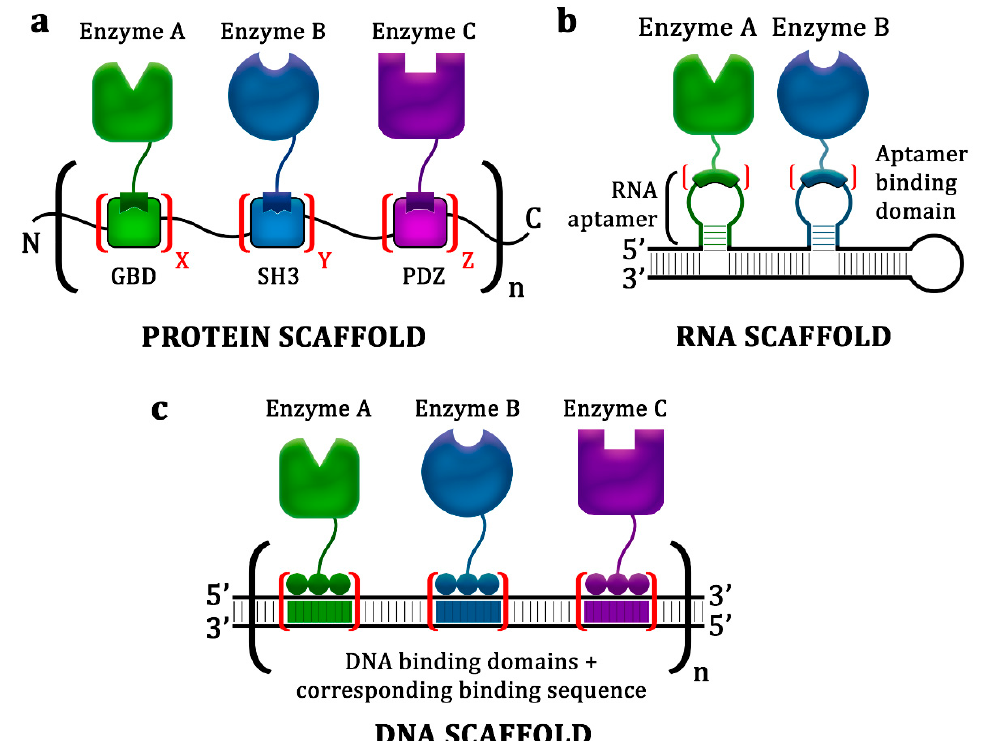
Figure 2. General approaches using the synthetic scaffolding strategy. ( a ) Protein scaffold system, where metazoan peptide motifs (i.e., GTPase-binding domain (GBD), Src homology 3 (SH3), and PSD95/Discs Large/ZO-1 (PDZ)) were exploited as scaffolds to anchor pathway enzymes that had been fused with peptide ligands associated with those domains. ( b ) RNA scaffold system, where synthetic noncoding RNAs containing aptamer structures were used as scaffolds to localize target enzymes that had been fused with appropriate aptamer-binding domains. ( c ) DNA scaffold system, where plasmid DNAs were used as scaffolds to dock target enzyme–DNA-binding protein (zinc finger protein of transcription activator-like effectors)